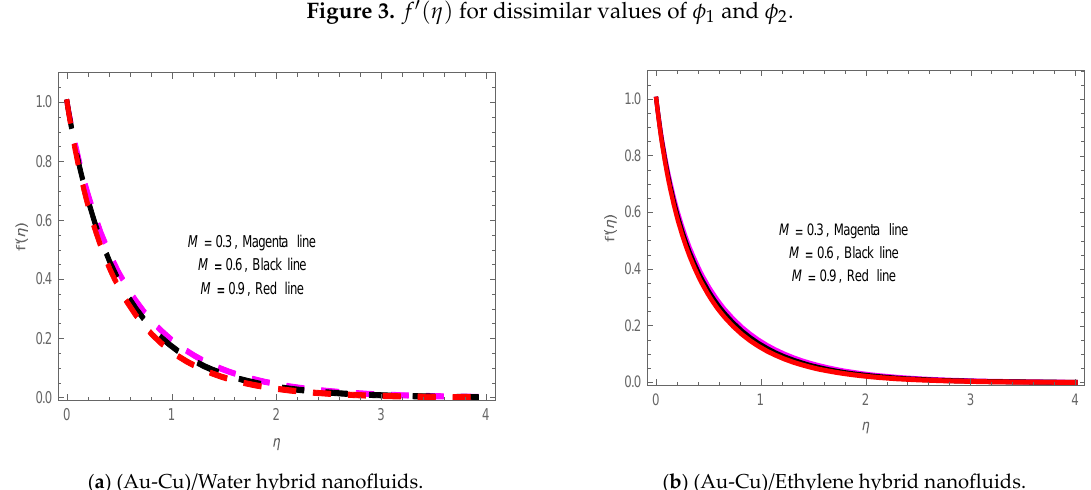
Figure 4. 𝑓 ′ (𝜂) for dissimilar values of M. Figure 4. f (cid:48) ( η ) for dissimilar values of M